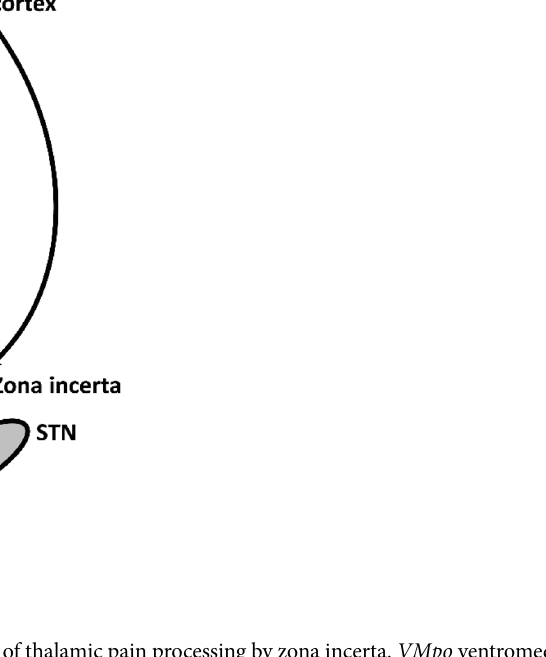
Figure 1. Feedforward inhibition of thalamic pain processing by zona incerta. VMpo ventromedial posterior nucleus.